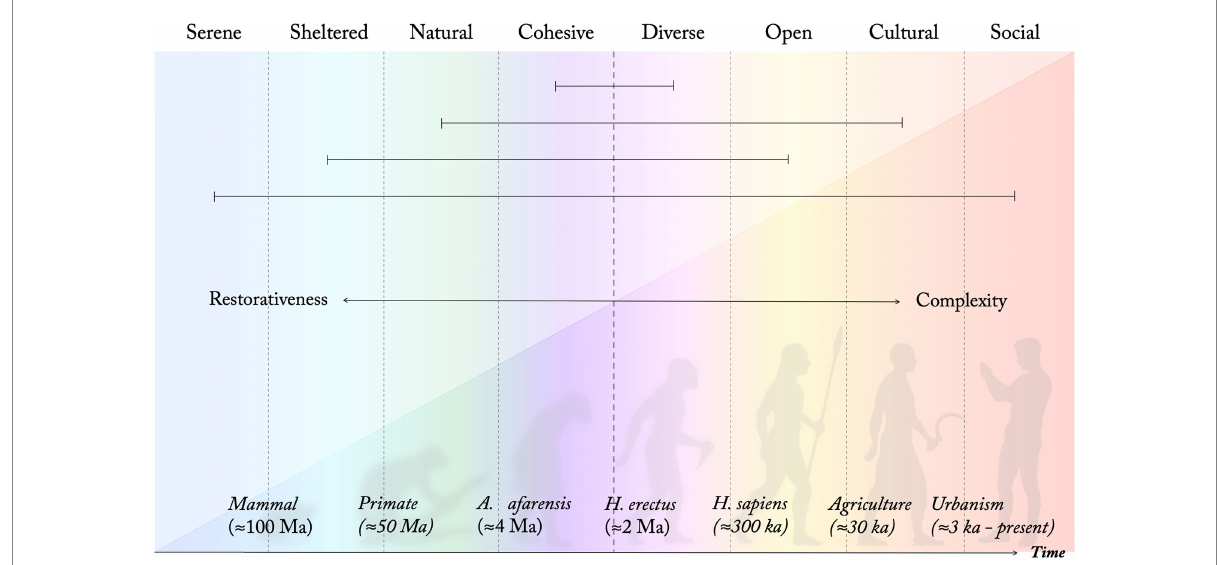
FIGURE 4 Eight perceived sensory dimensions of different development and restorative influence. As present-day perceived qualities and design principles they are understood along four axes of opposing qualities, connected with horizontal lines following the PSD model (Figure 1). (Schematic illustration. Time and species indications are estimations based on suggestions in the